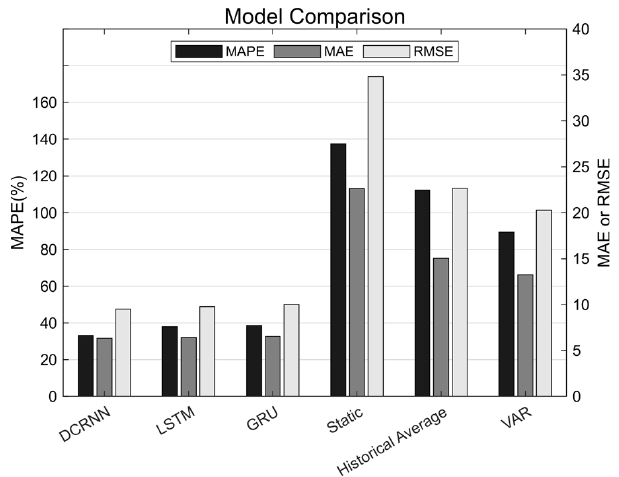
Figure 7. Model comparison between DCRNN and the baseline models .